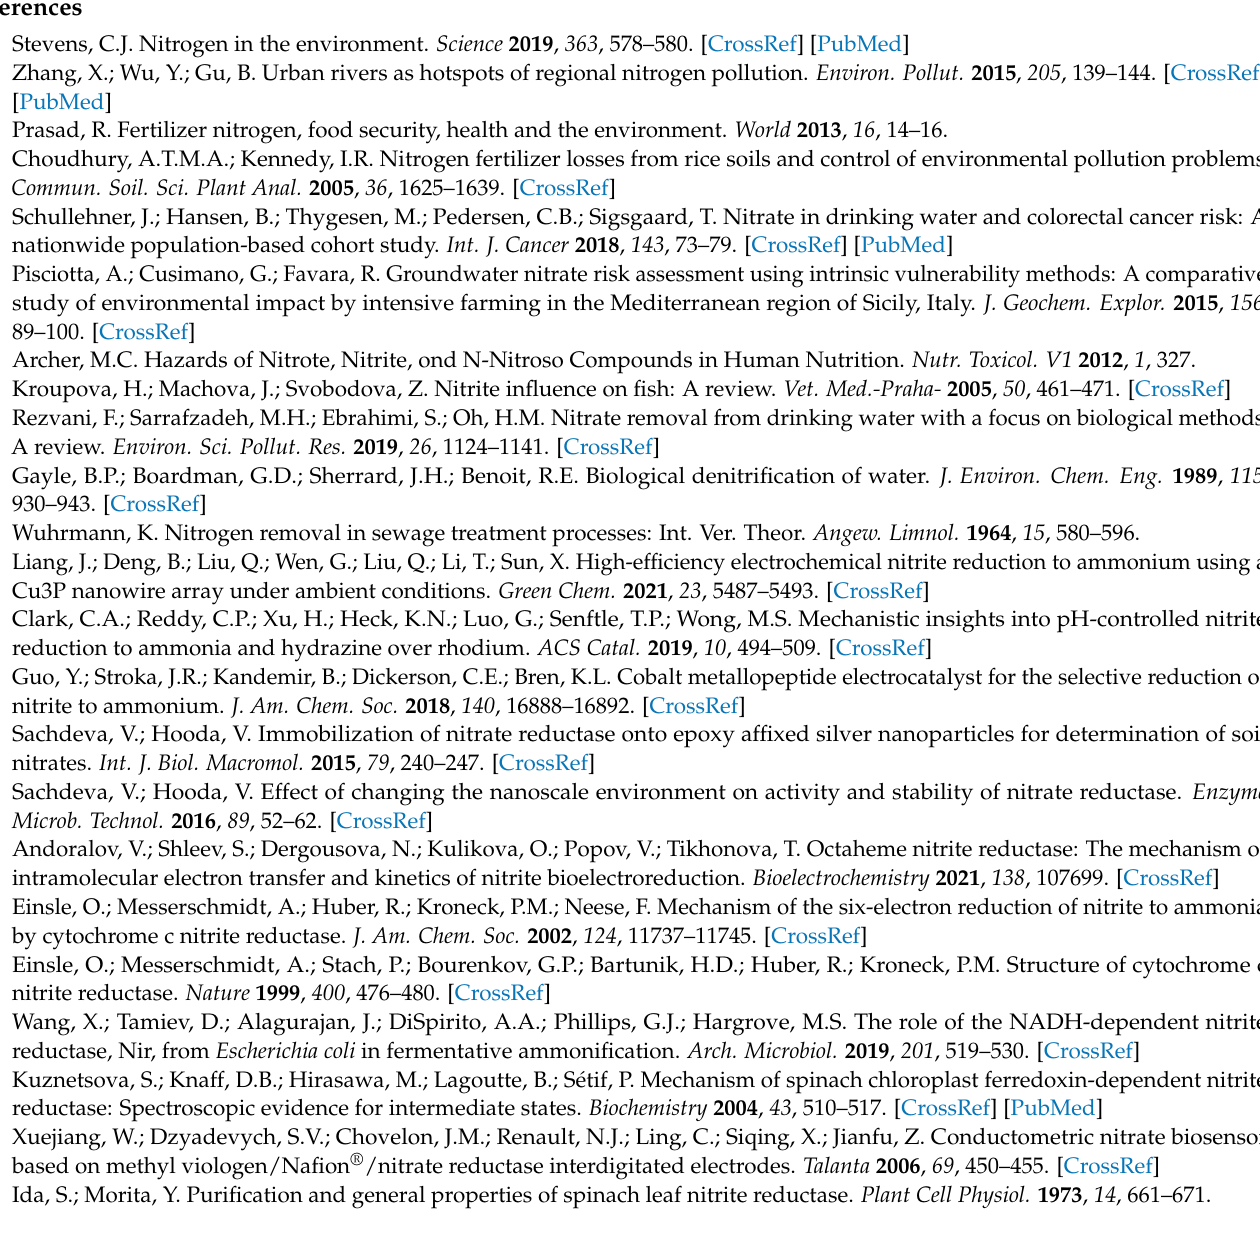
The sample solution of the activity test consisted of 4.7 mg/mL of spinach-derived